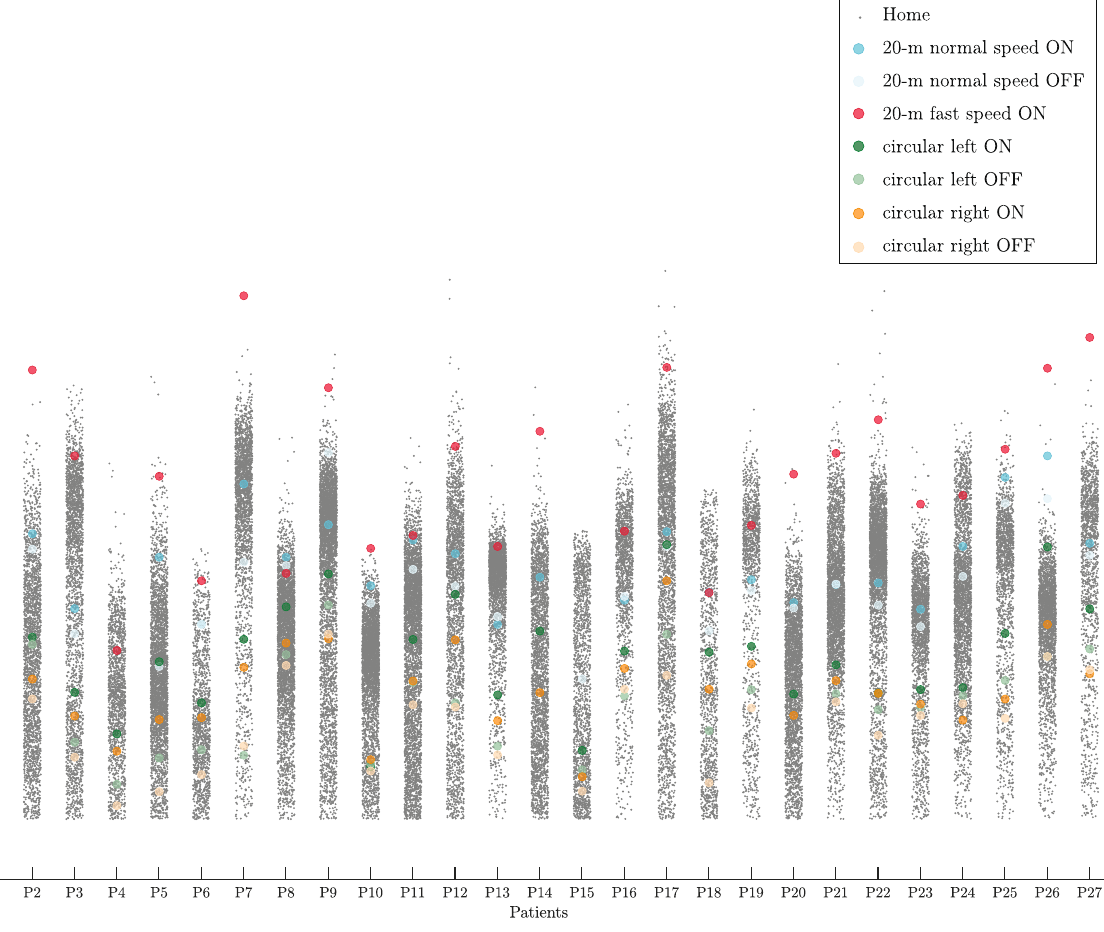
Fig. 1 Distribution of gait speed at home and the average values of the gait speed for the clinical assessments for each patient. For each patient, the average gait speed during the 20-m walking test was considered as their